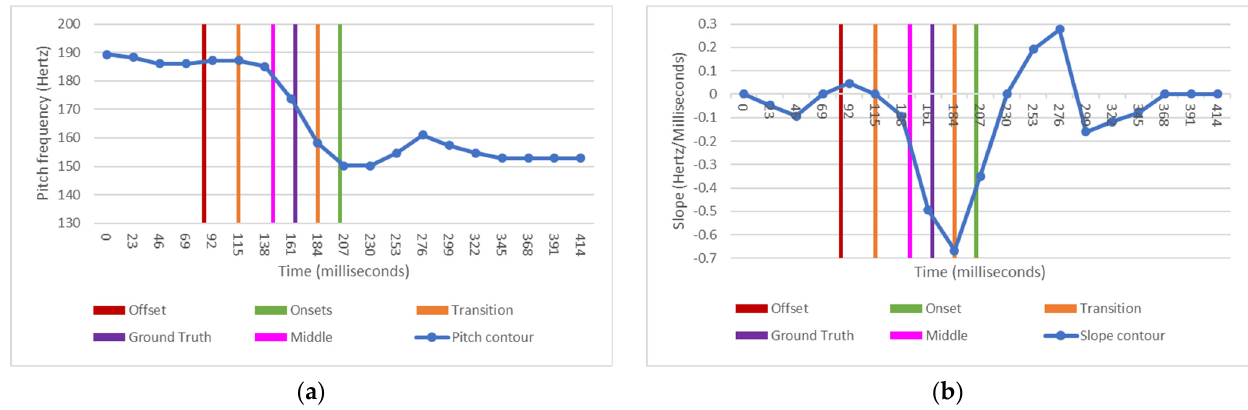
Figure 8. An example illustrates the position of the onset point in the Erkomaishvili dataset (ground truth) compared to the onset, offset, and transition points indicated by the proposed algorithm. Panel ( a ) shows the pitch frequencies, and panel ( b ) depicts the slope contour according to panel ( a